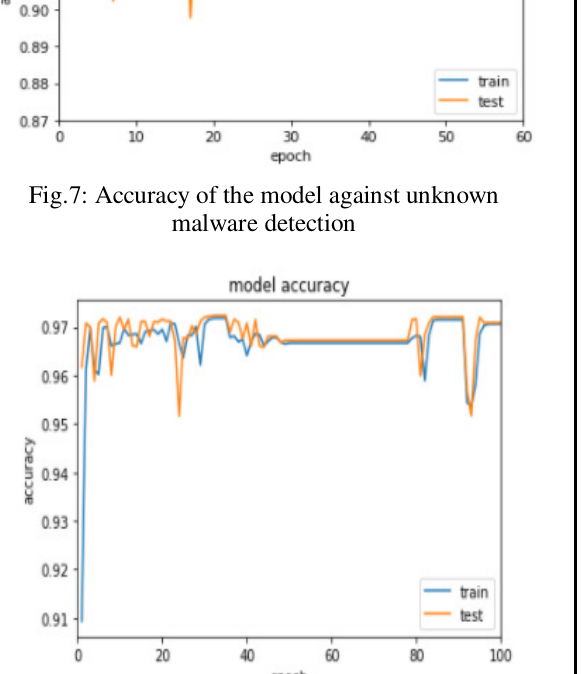
Fig.8: Accuracy of the model against unknown malware classification